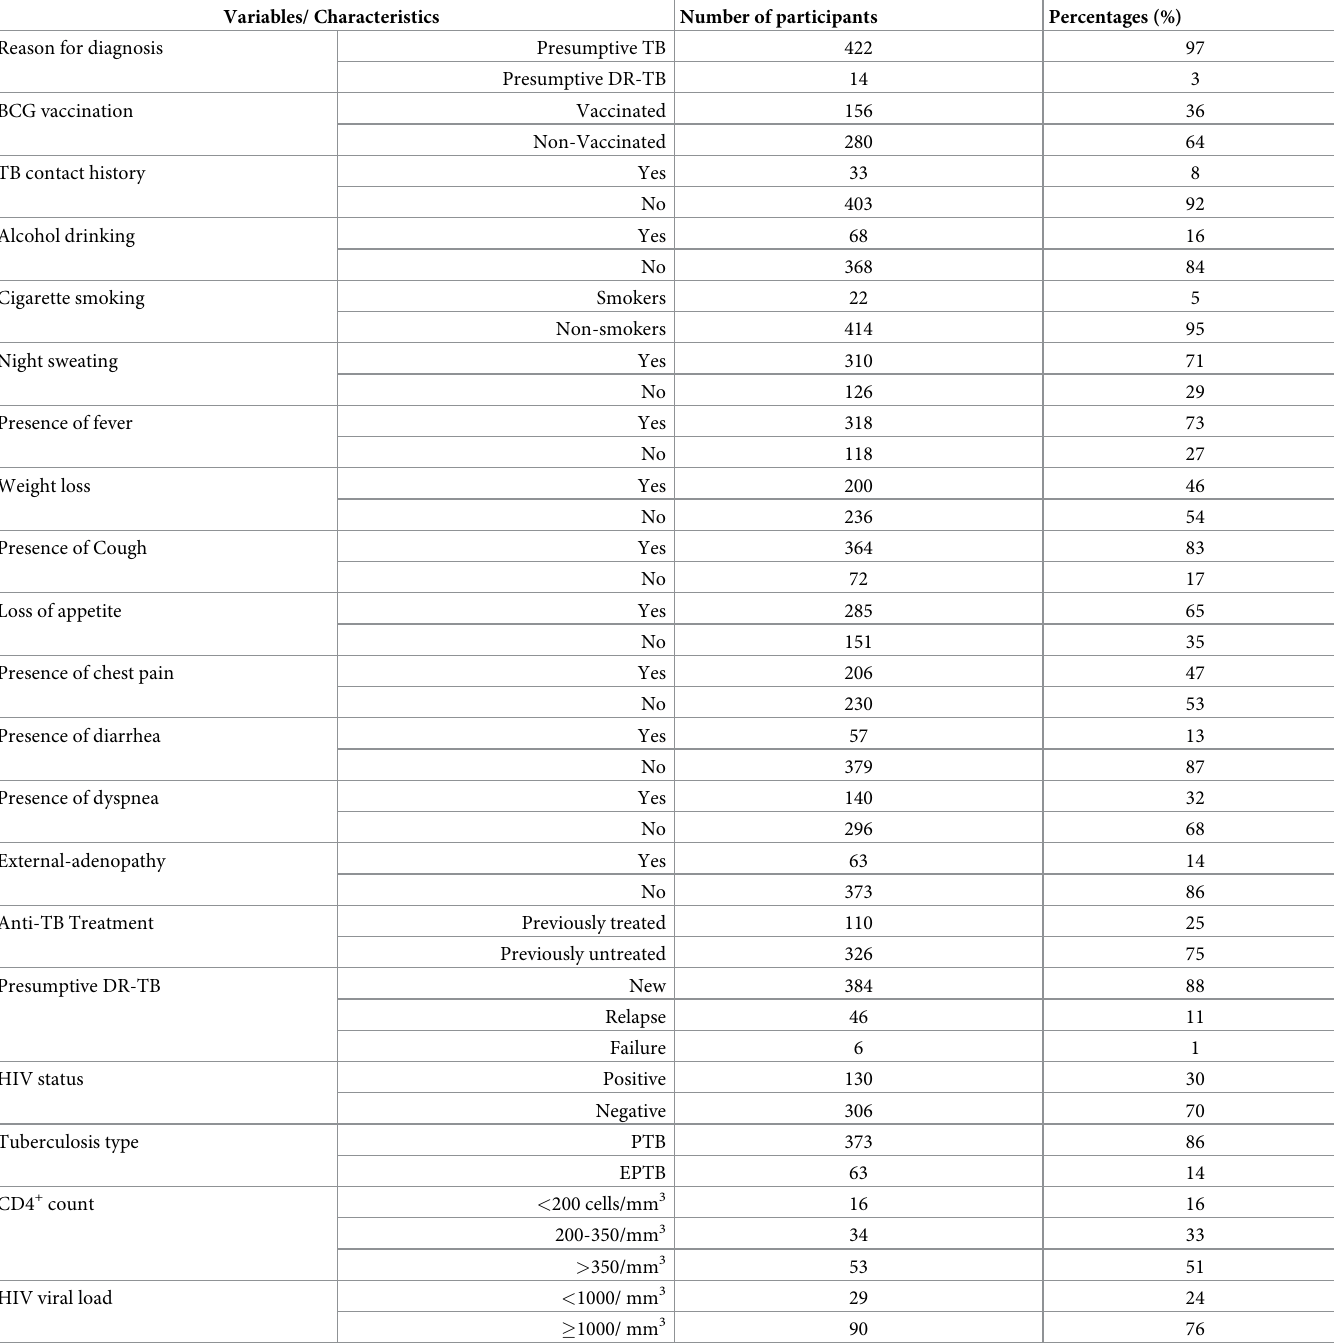
Table 2. Clinical characteristics participants among presumptive TB patients at SPHMMC, Addis Ababa, Ethiopia,